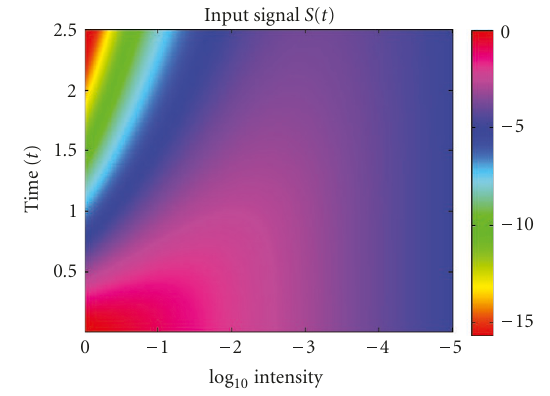
Figure 6: Input signal : the same as in Figure 4, but here the dynam- ics of the input signal S ( t , L ) is visualized (3).